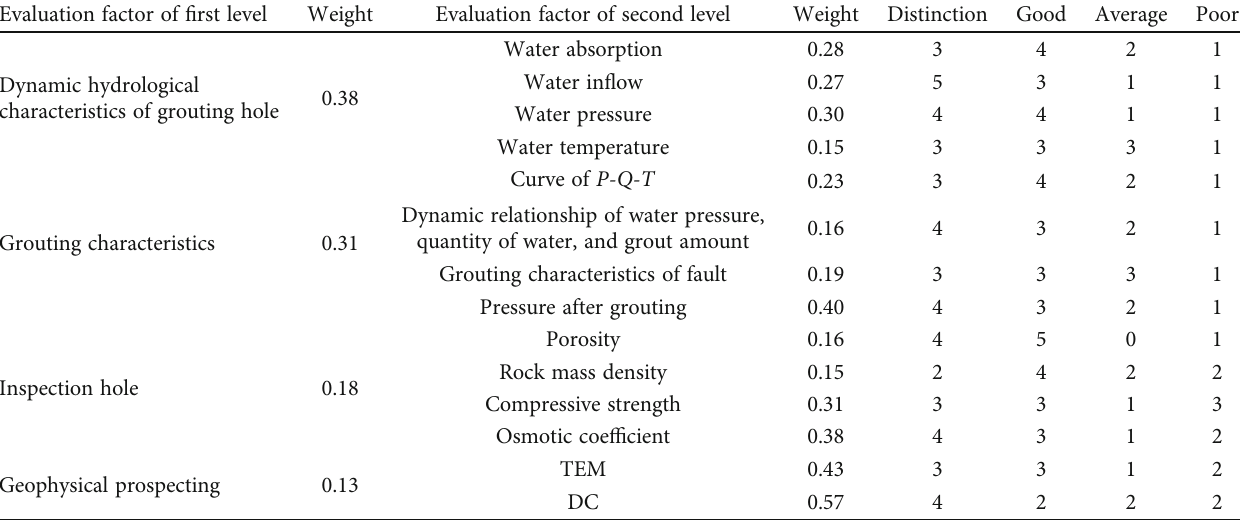
Table 3: The weight of the grouting evaluation on the 15092 coal workface of Guhanshan mine. Evaluation factor of fi rst